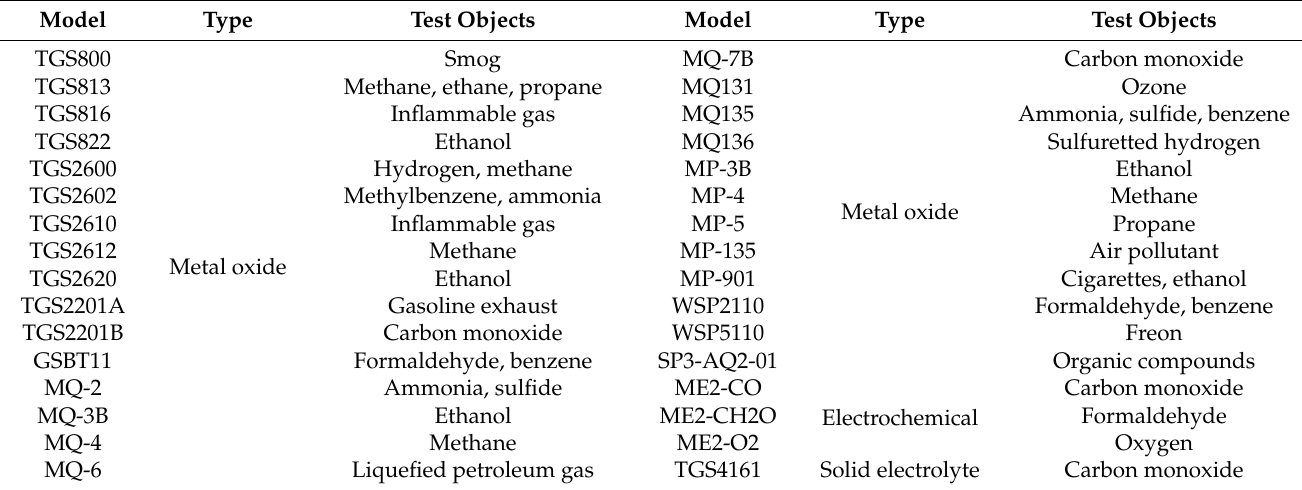
Table 2. Gas sensor details of our E-nose system.